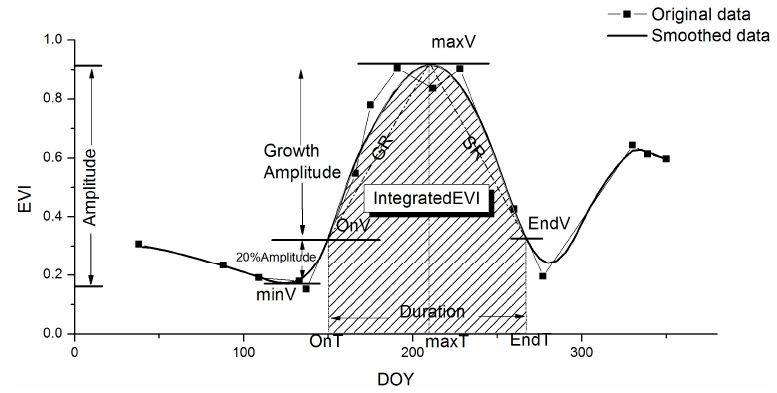
Figure 6. Calculation of phenological metrics.